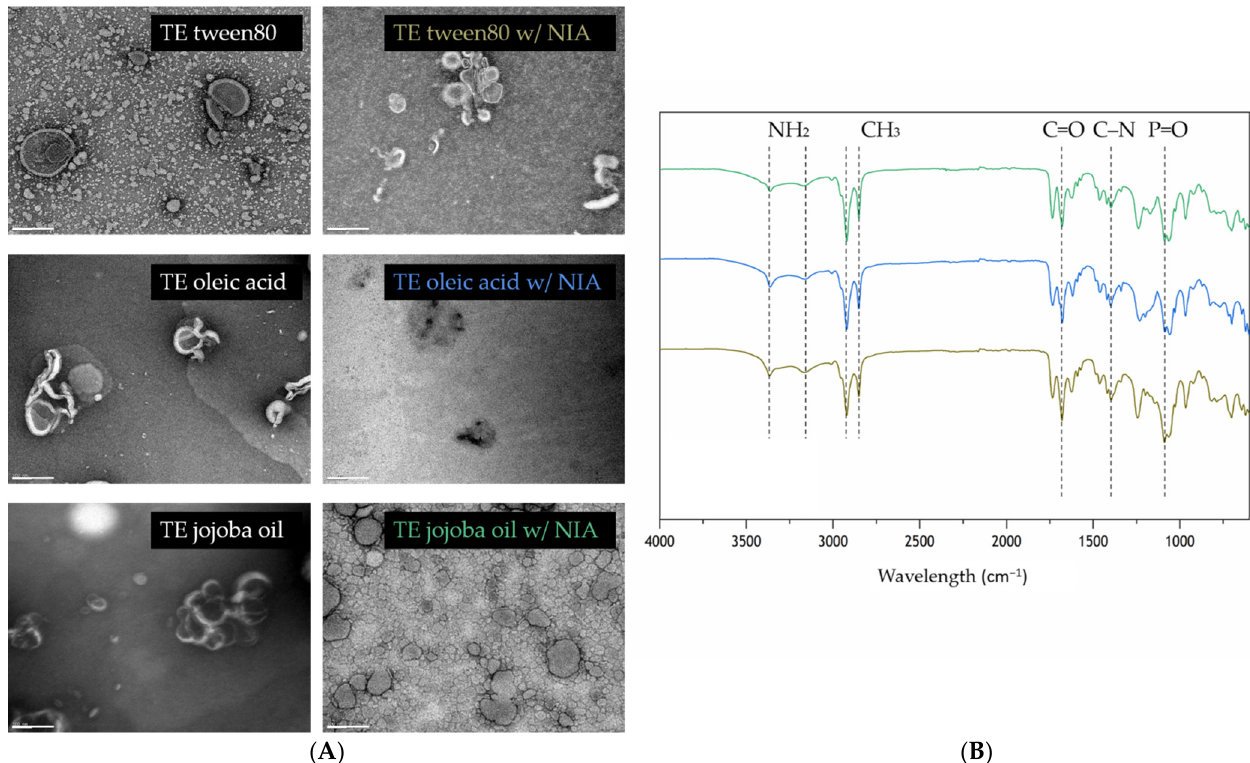
Figure 2. Analysis of NIA-loaded and non-loaded TEs morphology ( A ) and chemical interactions of NIA-loaded TEs ( B ). TEM of different types of TEs, with and without NIA. Scale bar 200 nm, amplification of 100,000 × . FTIR spectra of TE tween 80 w/NIA (bottom), TE oleic acid w/NIA (middle), and TE jojoba oil w/NIA (top) in relation to transmittance.